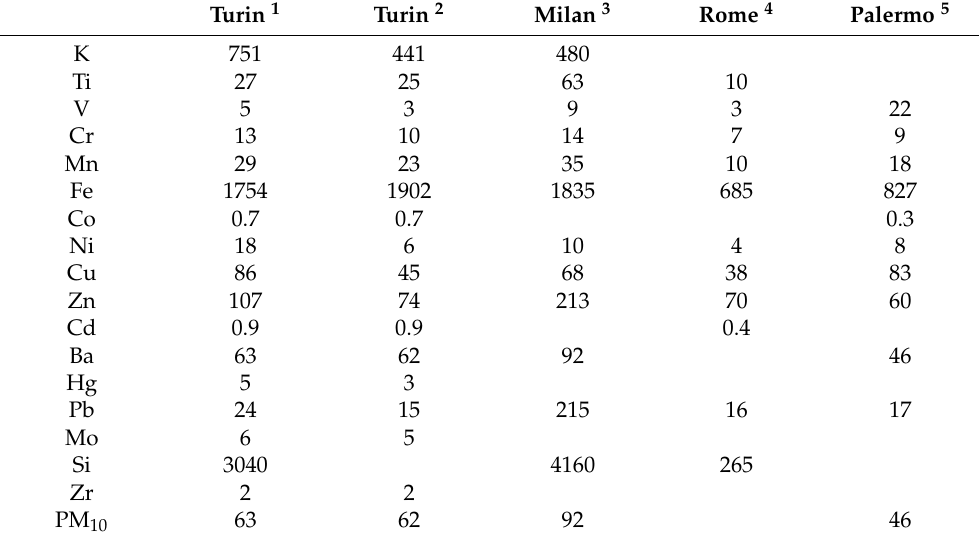
Table 5. Comparison of average element (expressed in ng m − 3 ) and PM 10 (expressed in µ g m − 3 ) concentrations in different Italian